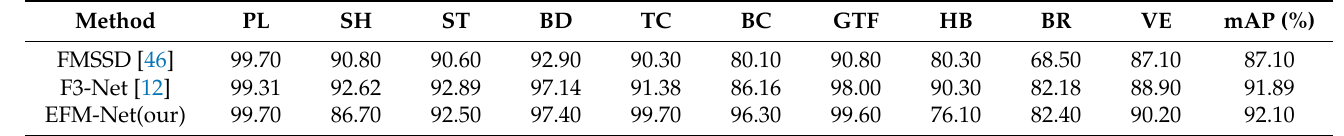
Table 4. Performance evaluation of the HBB task on the NWPU VHR-10